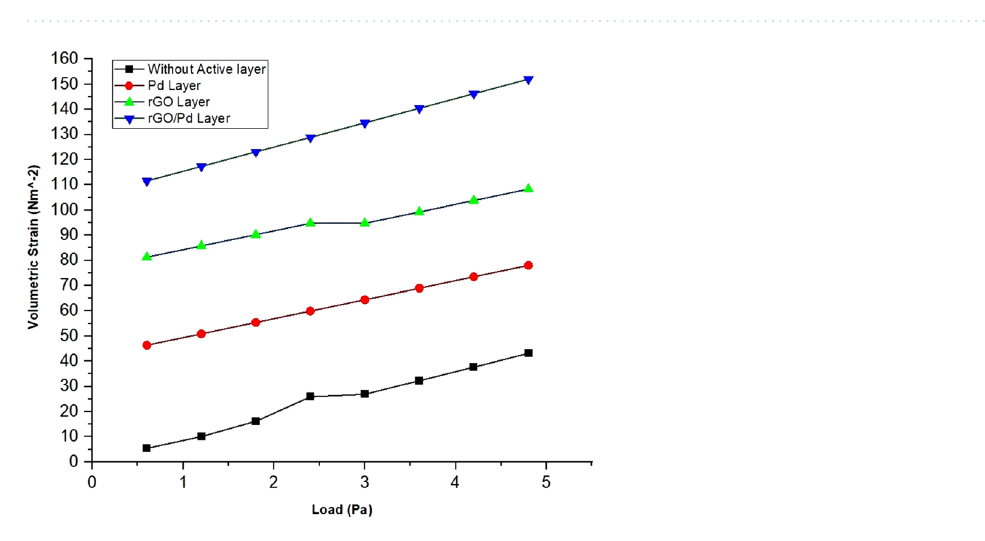
Figure 15. A Volumetric strain comparison of all four design for the same applied